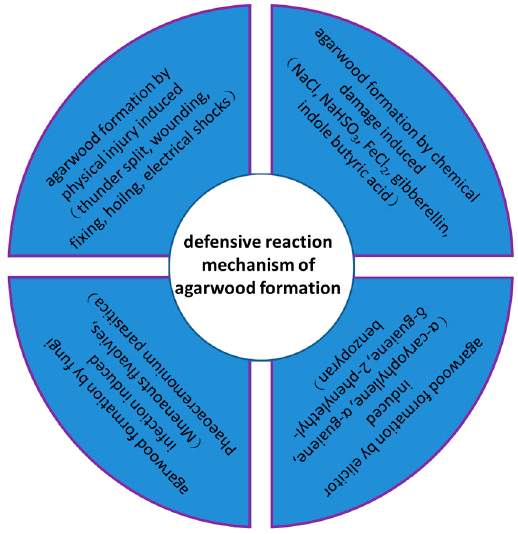
Figure 4. Defensive reaction mechanism of agarwood formation.